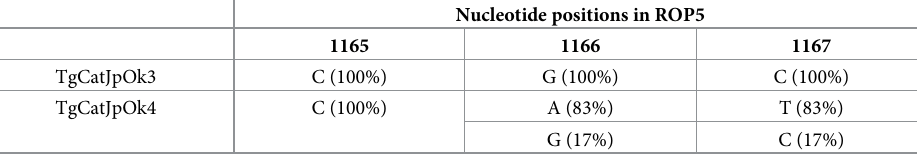
Table 3. The base composition in read sequences of TgCatJpOk3 and TgCatJpOk4 encoding an amino acid at position 389 of